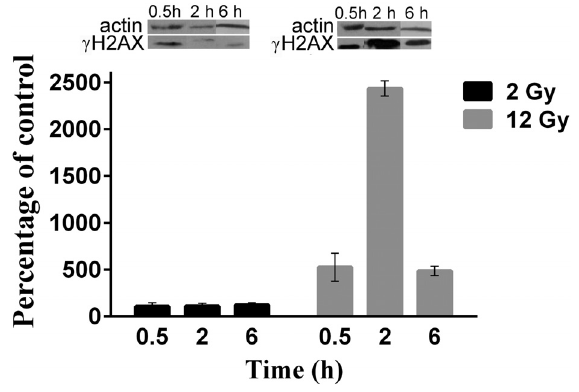
Figure 6 - Time dependent phosphorylation and dephospho- rylation of H2AX protein in HTB140 cells, given as percentage of control and analyzed by Western blot, after irradiation with 2 and 12 Gy γ -rays (C-control). Data obtained from 3 experiments are presented as mean ± SEM.